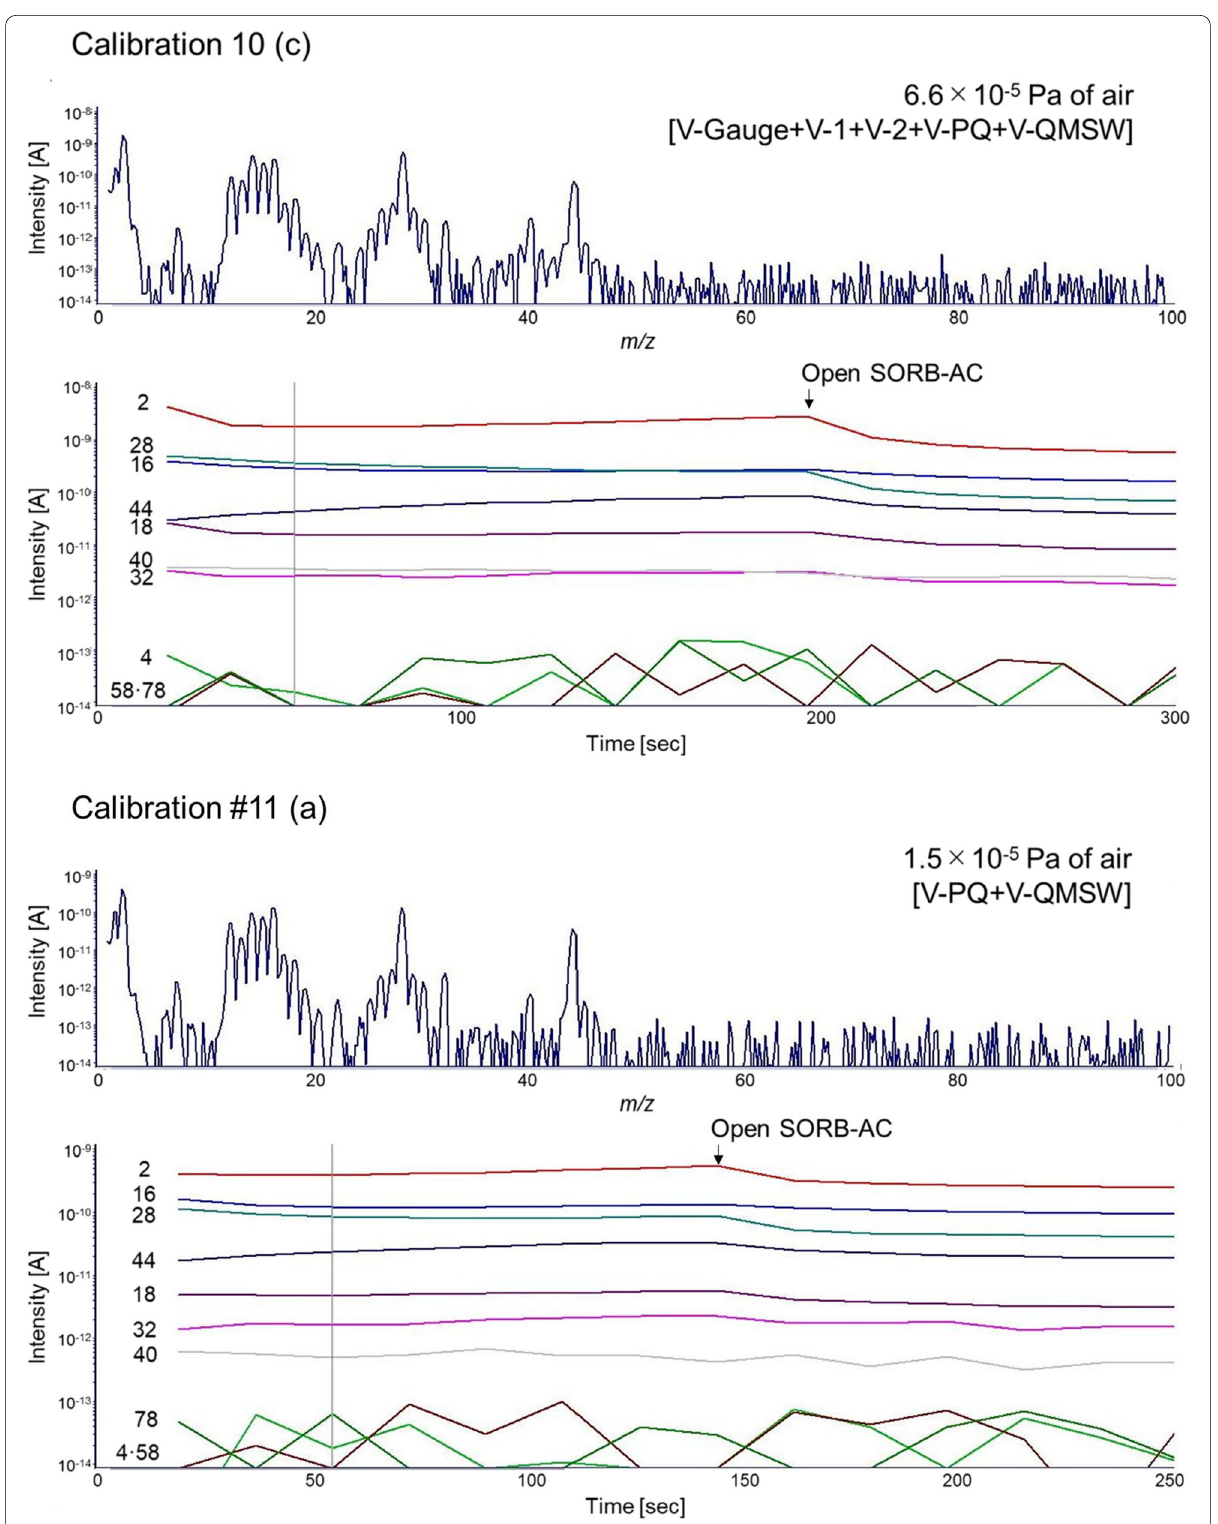
Fig. 8 Mass spectra for calibration gas measurements (calibration number of 10 (c), 11 (a) and 12) and a blank measurement. The mass spectra at 55 s after gas introduction (at top) and intensities of representative m/z spectra with time (at bottom) are shown. The amounts of calibration gases ∼ (the terrestrial atmosphere) and the areas to which the calibration gases were introduced during mass spectrometry are indicated. Other calibration conditions for the measurements are summarized in Table